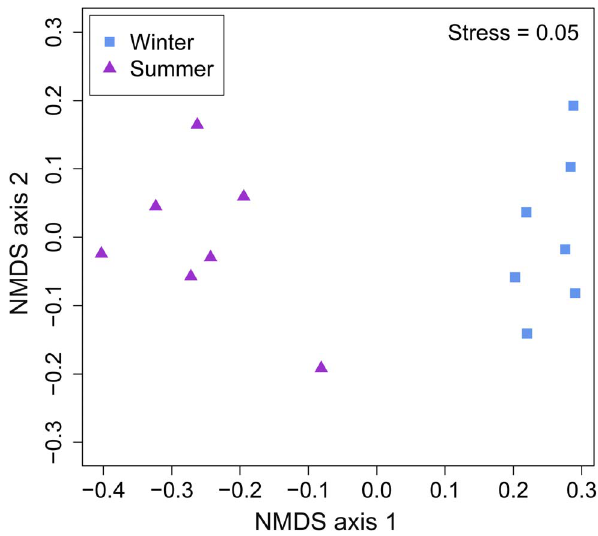
Figure 3. NMDS of Bray-Curtis pairwise dissimilarity of bacterial bioaerosol community in SCBs during the winter and summer seasons.